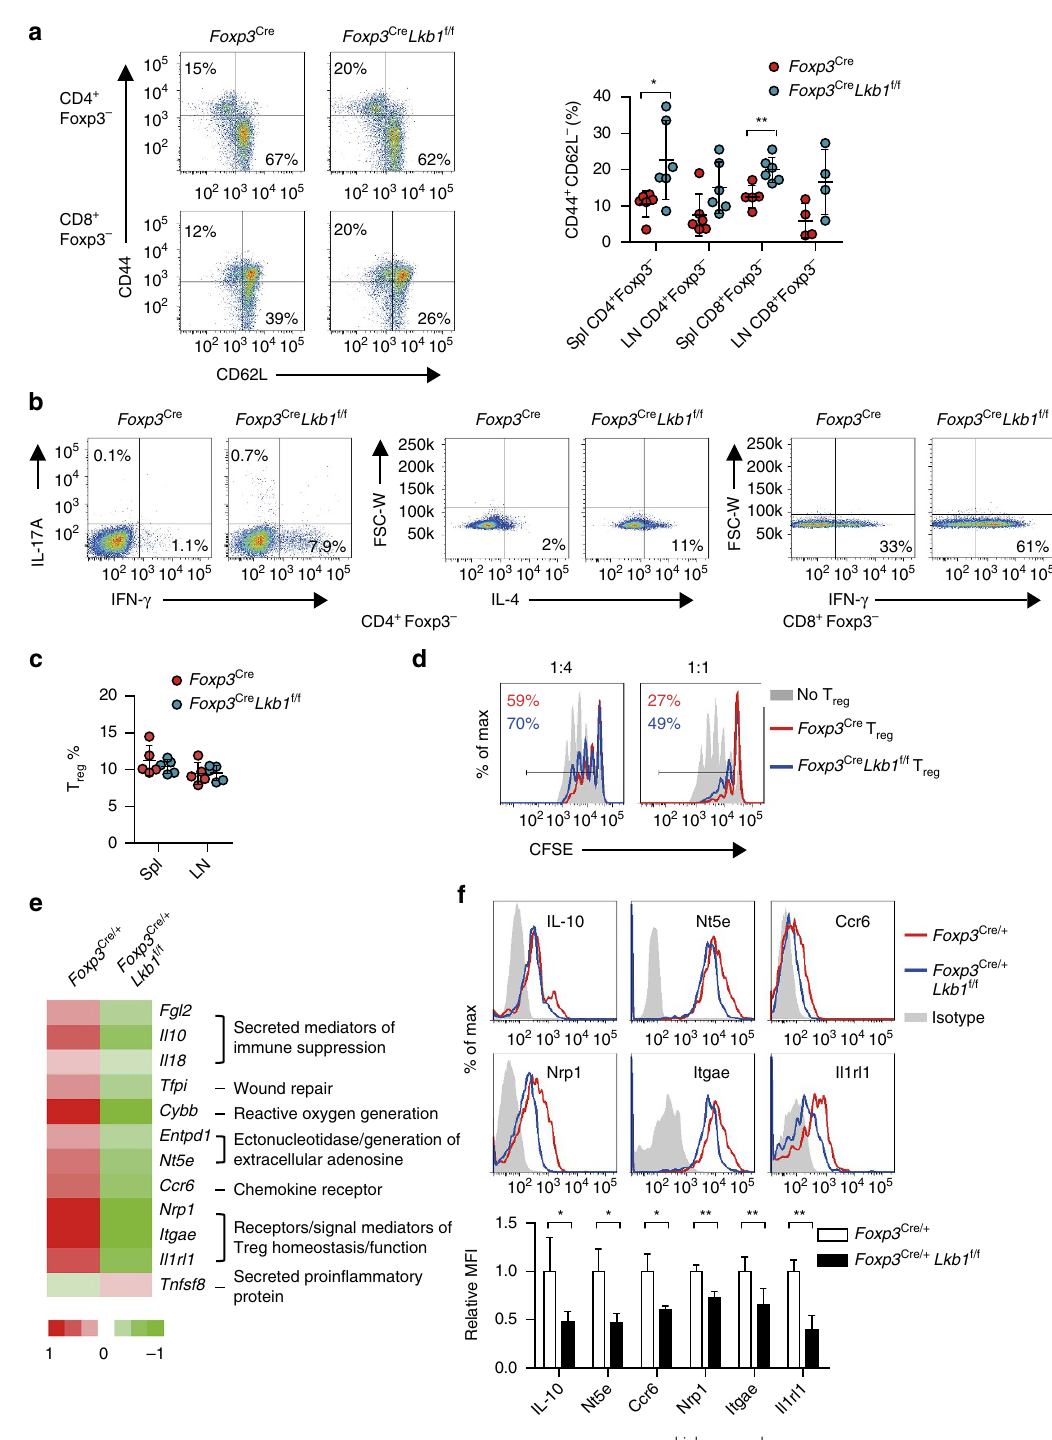
Figure 7 | Lkb1 promotes the expression of diverse immunosuppressive genes. ( a ) CD44 high CD62L low effector/memory cells among splenic CD4 þ Foxp3 (cid:2) and CD8 þ Foxp3 (cid:2) T cells from 9–11-day-old Foxp3 Cre and Foxp3 Cre Lkb1 f/f mice ( n ¼ 4–6). ( b ) Intracellular staining of cytokines in splenic CD4 þ Foxp3 (cid:2) and CD8 þ Foxp3 (cid:2) T cells from 9–11-day-old Foxp3 Cre and Foxp3 Cre Lkb1 f/f mice stimulated with phorbol myristate acetate (PMA) and ionomycin for 4h. ( c ) Percentages of Foxp3 þ T reg cells among CD4 þ Tcells in the spleen and lymph nodes from 9–11-day-old Foxp3 Cre and Foxp3 Cre Lkb1 f/f mice ( n ¼ 5). ( d ) Suppression of proliferation of CFSE-labelled T n cells (responding cells, T resp ) by different ratios of CD4 þ YFP þ T reg cells from Foxp3 Cre and Foxp3 Cre Lkb1 f/f mice. T resp cell division was determined by CFSE dilution at the indicated ratios of cell numbers between T reg cell and T resp cells. The experiment was repeated three times. ( e ) T reg cell function-related genes differentially expressed between CD4 þ YFP þ T reg cells from Foxp3 Cre/ þ and Foxp3 Cre/ þ Lkb1 f/f mice determined by transcriptional profiling, shown in groups based on their functions. Fold difference means fold change of gene expression levels in T reg cells from Foxp3 Cre Lkb1 f/f mice compared with that from Foxp3 Cre mice. ( f ) Expression of indicated proteins on splenic T reg cells from Foxp3 Cre/ þ and Foxp3 Cre/ þ Lkb1 f/f mice ( n ¼ 3). Two-way analysis of variance (ANOVA) was used for statistical analyses in ( a , c , f ) (* P o 0.05, ** P o 0.01); error bars represent s.d.; all data are representative of at least two independent experiments.